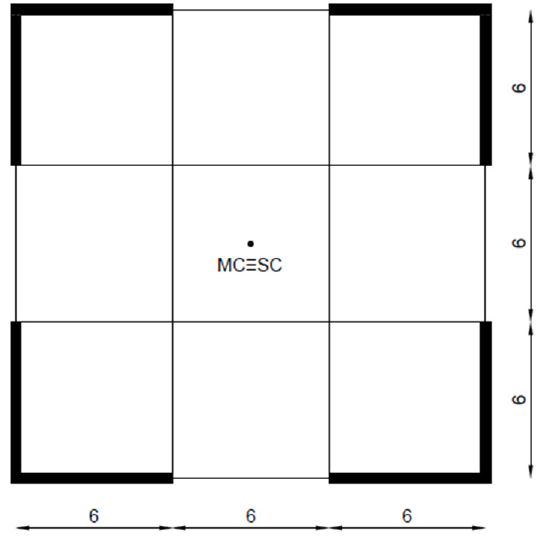
Figure 22. Plan of the multi-storey building (measurements in m).